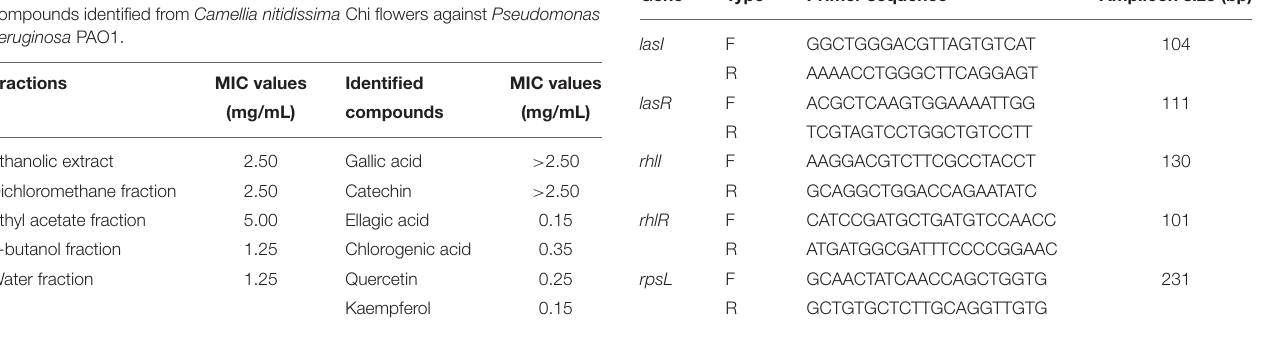
TABLE 2 | Primers used for quorum sensing circuit genes lasI , lasR , rhlI , and rhlR , and reference gene, rpsL .